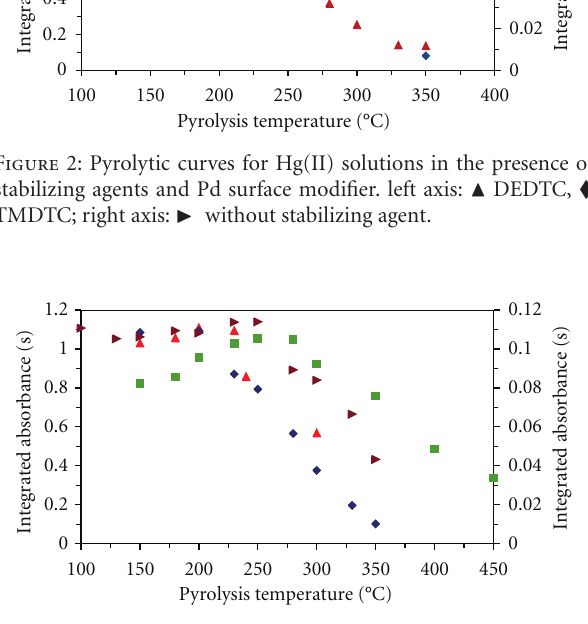
Figure 3: Pyrolytic curves for Hg(II) solutions in the presence of stabilizing agents and Re surface modifier. left axis: (cid:5) thiourea (deuterium background correction), (cid:2) DEDTC, (cid:3) TMDTC; right axis: (cid:4) without stabilizing